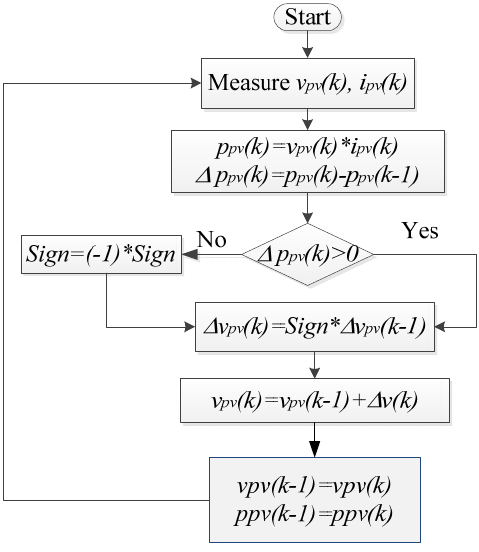
Figure 17. Flowchart of the Perturb and Observe (P & O) algorithm.